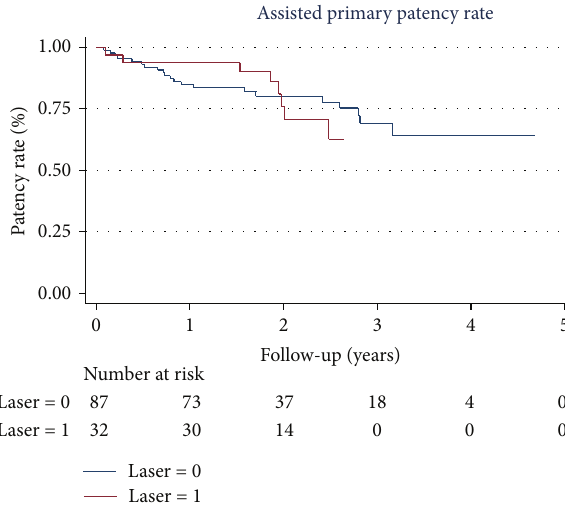
Figure 3: The Kaplan-Meier curve for assisted primary patency. Laser 1 and laser 0 mean group A and group B,